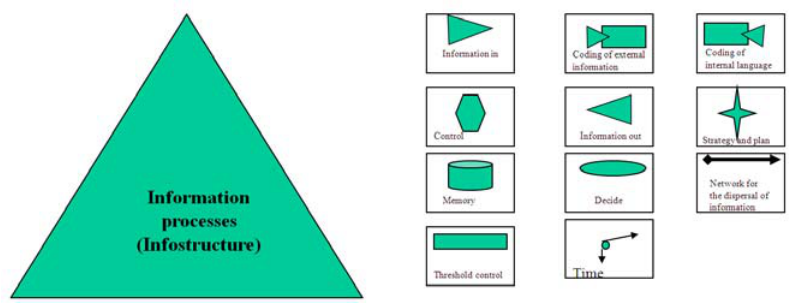
Fig. 2. Infostructure